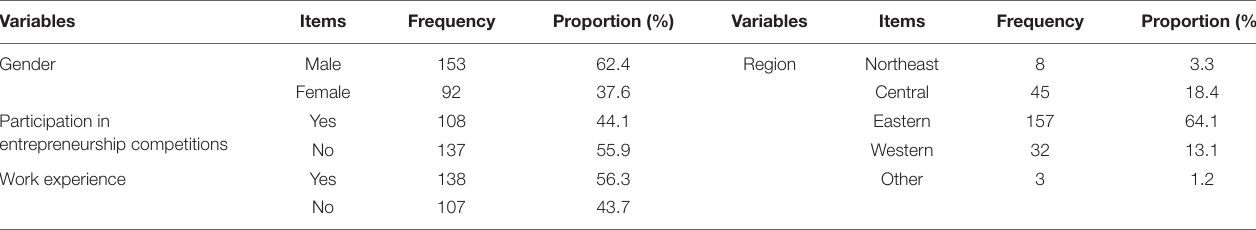
TABLE 1 | Sample characteristics ( N = 245).